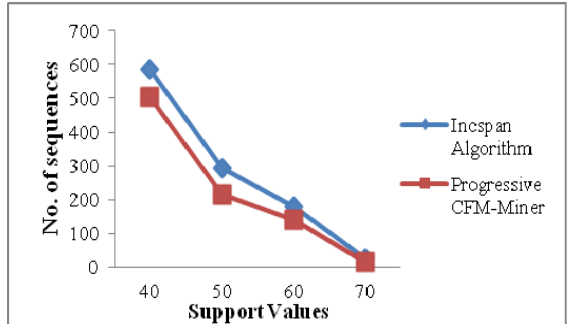
Fig.6. Generated Sequential Patterns with Different Support Values